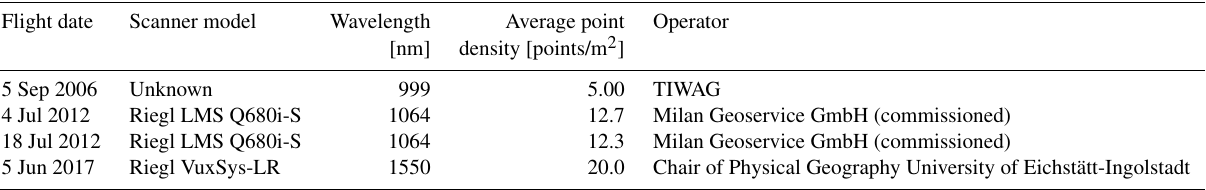
Table 2. Overview of ALS data used for flow velocity analysis and surface elevation change analysis. Average point density is given for the areas of the investigated rock glaciers without snow